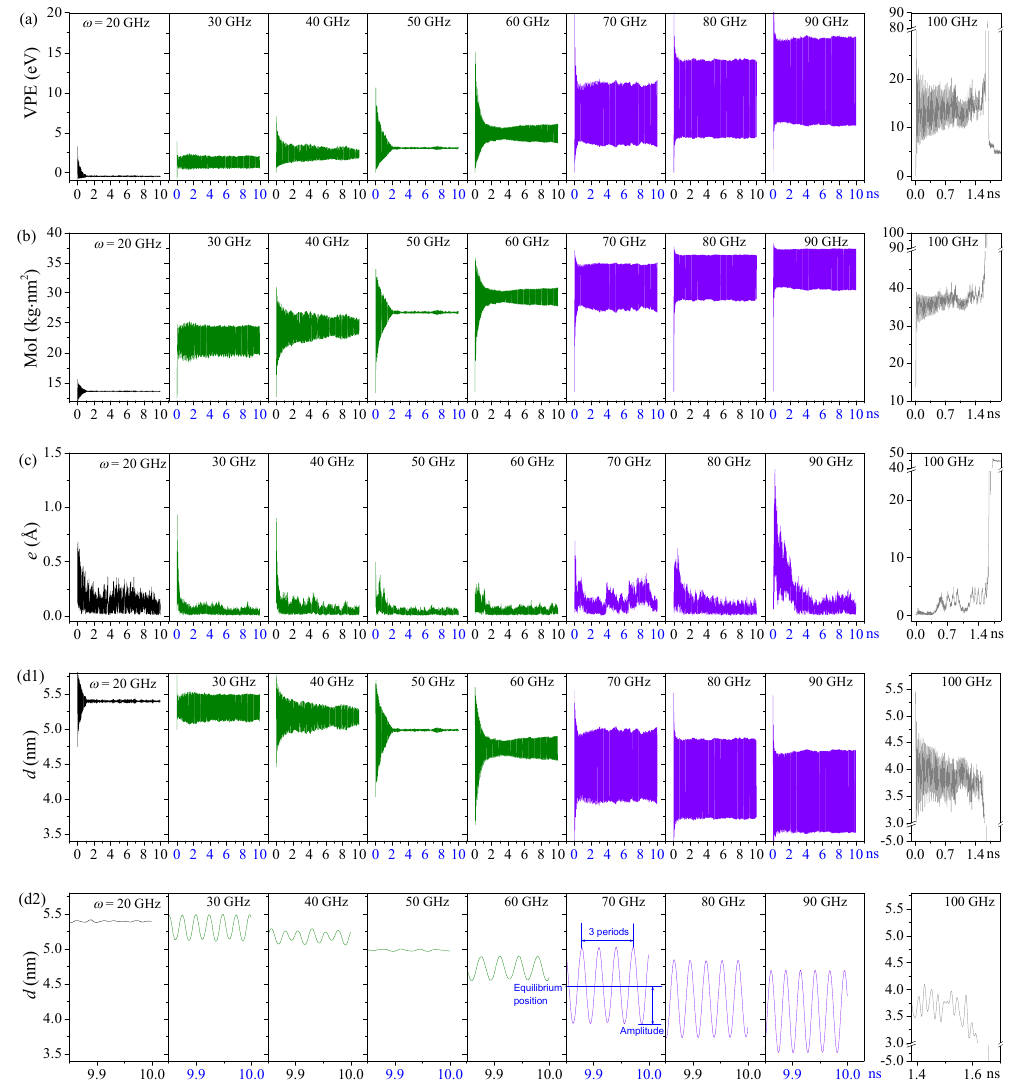
Figure 1. Historical curves of dynamic outputs for the Z2H6 system under different rotation frequencies at 8 K: ( a ) variation of the potential energy (VPE) of the HDP, ( b ) moment of inertia (MoI) of the HDP about the z-axis, ( c ) eccentricity ( e ) of the HDP from the z-axis, ( d1 ) the axial translation of the R-rotor, d , and ( d2 ) the amplified view of d during [9.85, 10.00] ns “ZmHn” means n columns of carbon atoms on HDP with an axial length of Zm are hydrogenated, e.g., Z2H6 indicates six columns hydrogenated carbon atoms on the HDP with a length of Z2. Details of the HDP are given in Section 3 . When the input rotational frequency is low, e.g., ω = 20 GHz, the VPE remained unchanged soon after 2 ns, which meant that the shape of the HDP changed slightly during rotation (Figure 2a). The reason was that the two hydrogenated parts on the HDP, i.e., the areas with internal carbon– hydrogen (C–H) bonds, were attached via the strong van der Waals (vdW) force, and the centrifugal force was not high enough to separate them. However, once ω reached 30 GHz, the centrifugal force on the HDP was strong enough to overcome the vdW force and separate the C–H areas apart. Simultaneously, HDP was undertaking breathing vibrations (Figure 2). This was the reason why the VPE curves kept fluctuating.